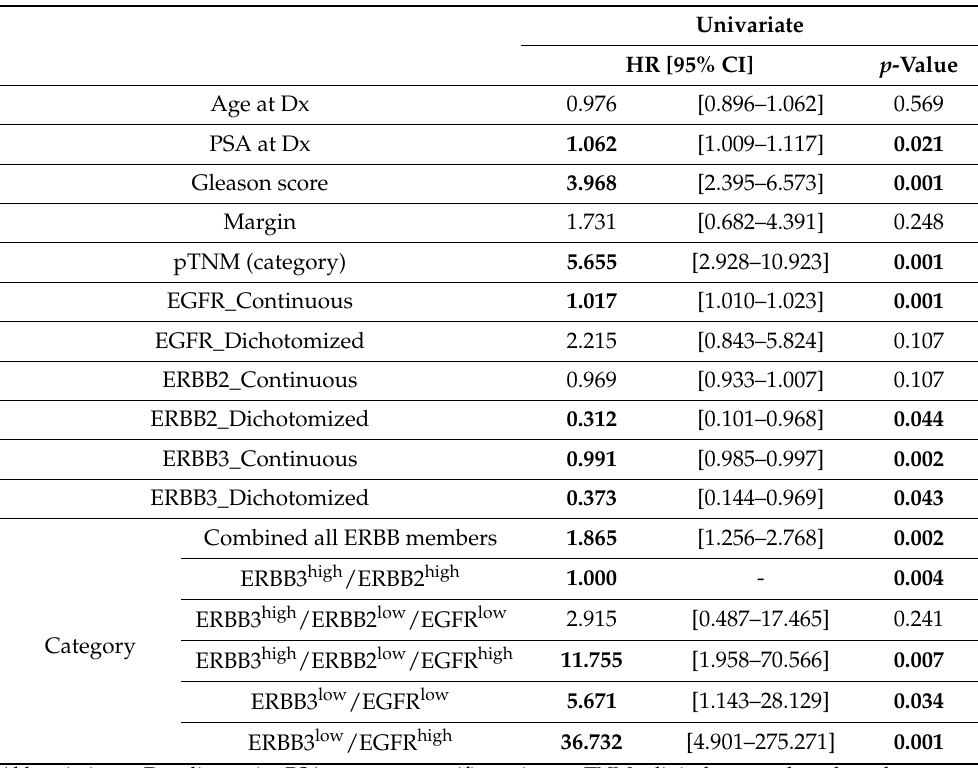
Table 5. Univariate Cox regression analyses of ERBBs using prostate cancer-specific mortality as an